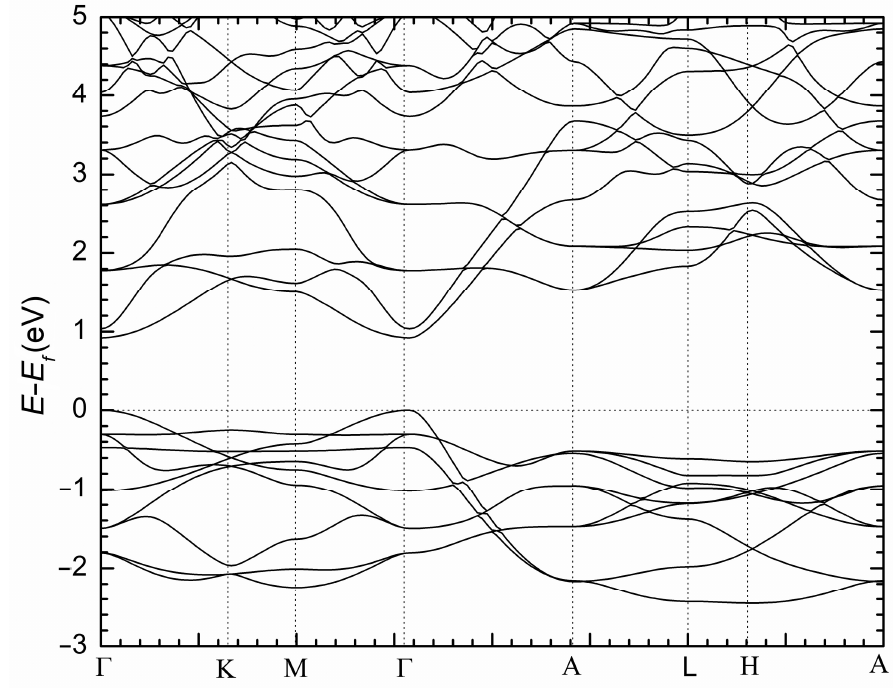
Figure 5. Electronic structure of NaBaSb.